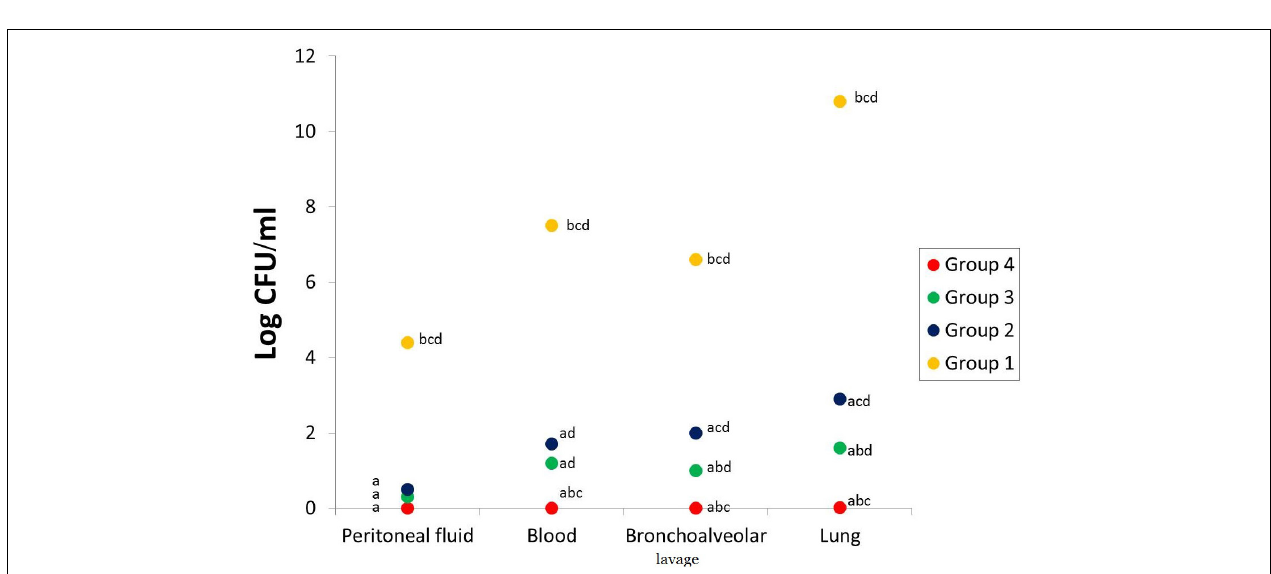
FIGURE 4 | Bacterial count in the peritoneal lavage, blood, bronchoalveolar lavage, and lungs of different rat groups. a Significant difference compared to PN group. b Significant difference compared to VIT C group. c Significant difference compared to AB group. d Significant difference compared to VIT C+AB group. PN, pneumonia; VIT C, vitamin C; AB,